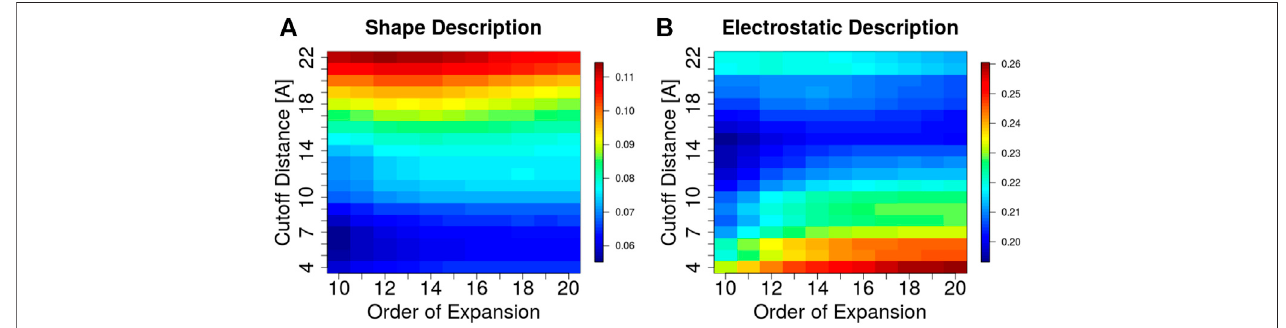
FIGURE 4 | Surface complementarity of antibody-antigen interacting surfaces based on shape (A) and electrostatic (B) 3DZD descriptors as a function of the interaction cutoff distance (y-axis) and order n of the series expansion